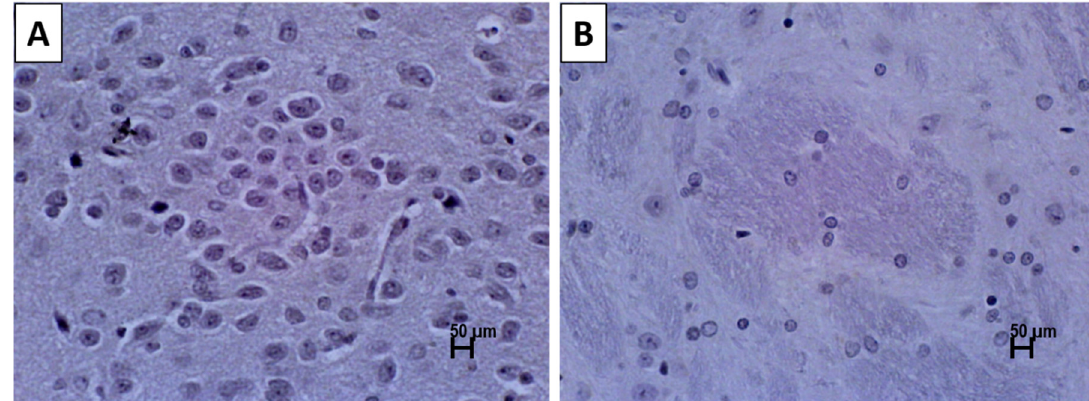
Figure 3. Photomicrographs showing the immunohistochemistry (IHC) without primary antibody for tyrosine hydroxylase (TH) in the coronal sections of ( A ) substantia nigra without detectable dopamine (DA) neurons, and ( B ) striatum without detectable DA fibres. Scale bar: 50 µm.